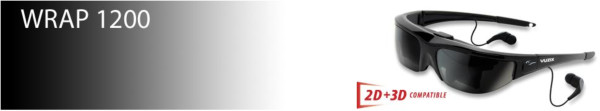
Vuzix illustration. The Vuzix eyewear should allow ambulatory P300-based BCI.